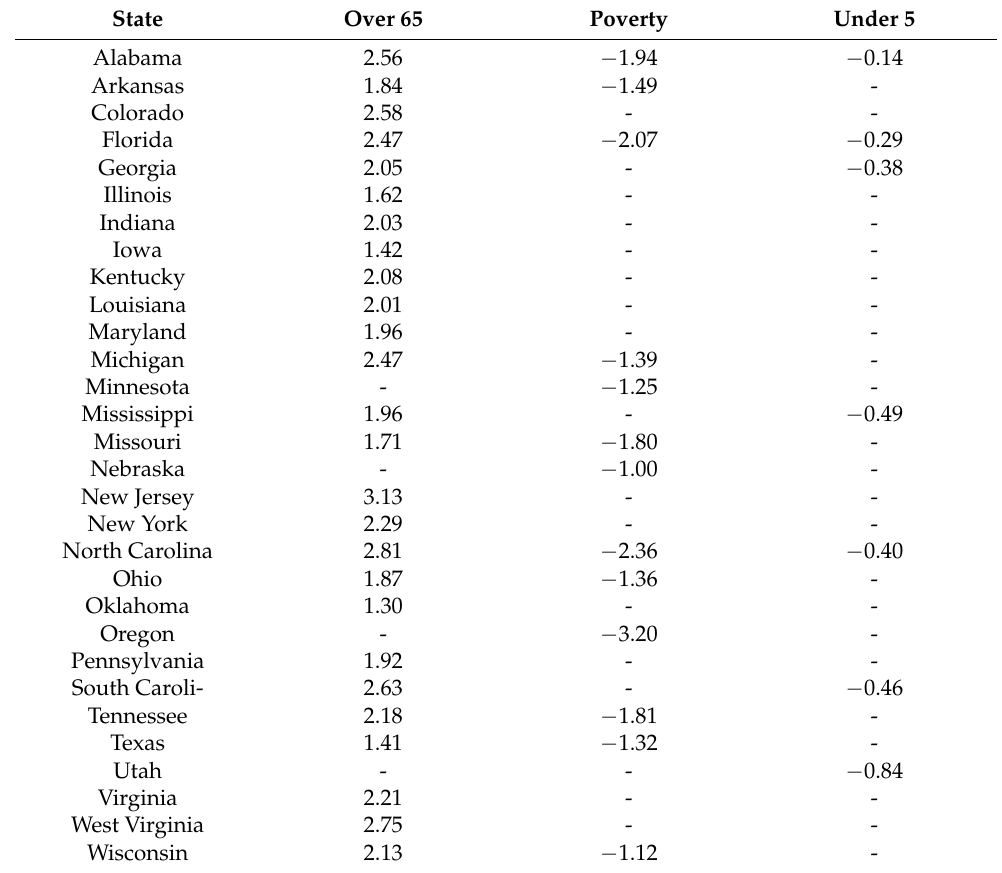
Table 1. Significant changes in percentage of the vulnerable population from 2010~2014 to 2015~2019. Positive values show an increase from the first 5-year period to the second study period, and negative values indicate a decrease in